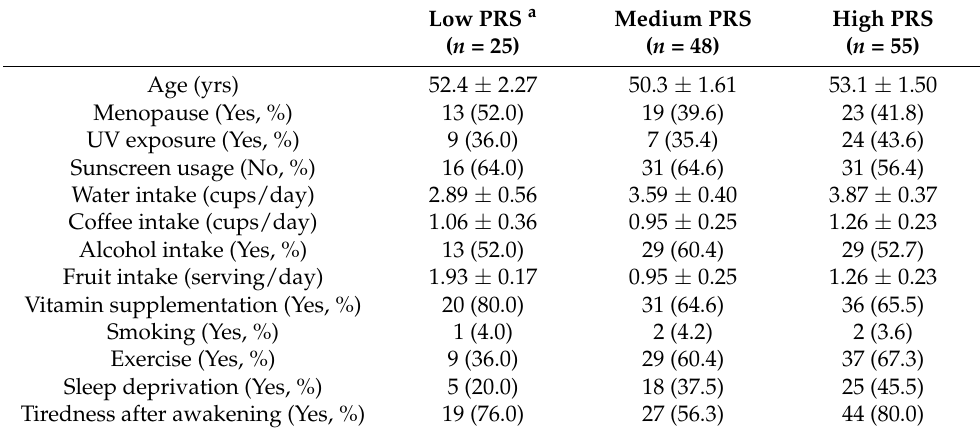
Table 4. Adjusted means of demographic characteristics of the participants according to polygenetic risk scores (PRSs) related to collagen metabolism.